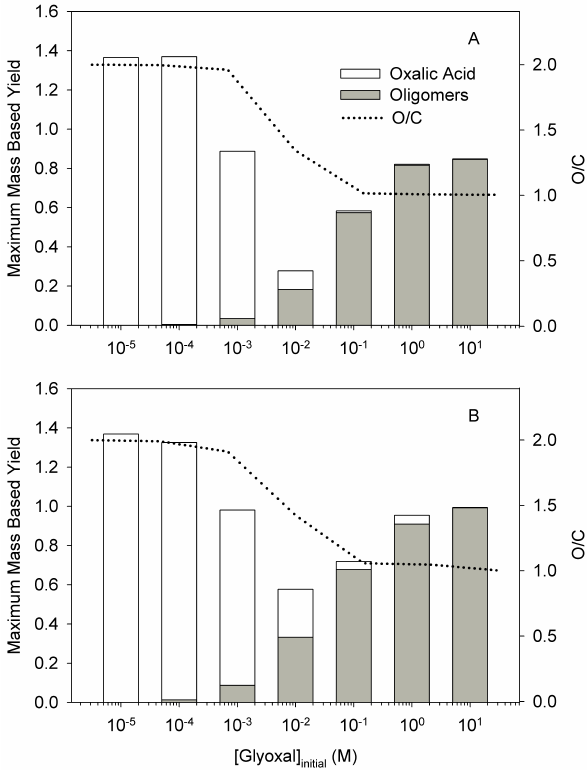
Fig. 9. Predicted maximum mass based yields (in the left y axis) of oxalic acid and oligomers (C 3 +C 4 dimers) with increasing ini- tial concentrations of glyoxal for aqueous-phase reactions with OH radicals: (A) for lab conditions (OH radical is generated by H 2 O 2 photolysis; H 2 O 2 also reacts with glyoxylic acid reducing yields; [H 2 O 2 ] = 5 × [Glyoxal] initial ) , and (B) for atmospheric conditions ([OH] aq is constant; H 2 O 2 is zero). For case A, [OH] aq is (1–10)e- 12M. For case B, [OH] aq is 2.8e-12M. Simulated pH is 4.8–1.5 at low to high [Glyoxal] initial . Similarly, O/C ratios (in the right y axis) with increasing initial glyoxal concentrations: (A) for lab conditions and (B) for atmospheric